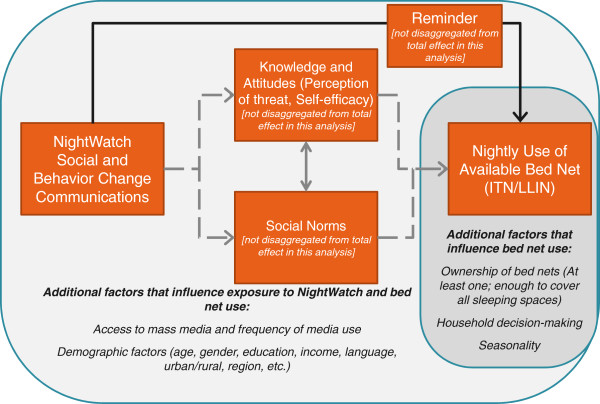
NightWatch theory of causality. Hypothesized channels through which NightWatch directly and indirectly impacts malaria control behaviour.